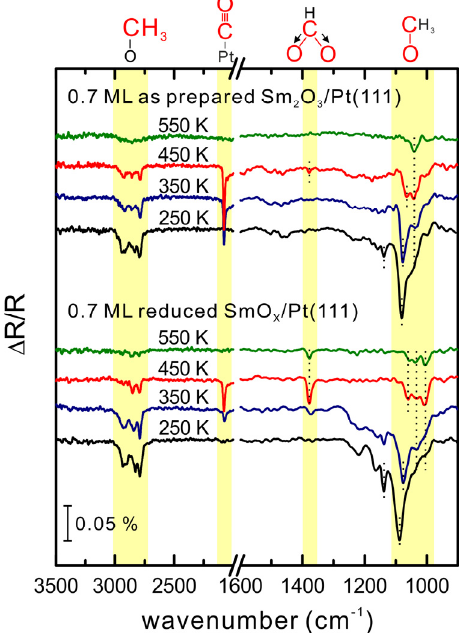
Figure 6. Temperature-dependent IRRAS spectra collected after dosing 15 Langmuir MeOH on a 0.7 ML as-prepared Sm 2 O 3 /Pt(111) and its thermally-reduced SmO x /Pt(111) surfaces at 96 K and subsequently annealed to particular temperatures.